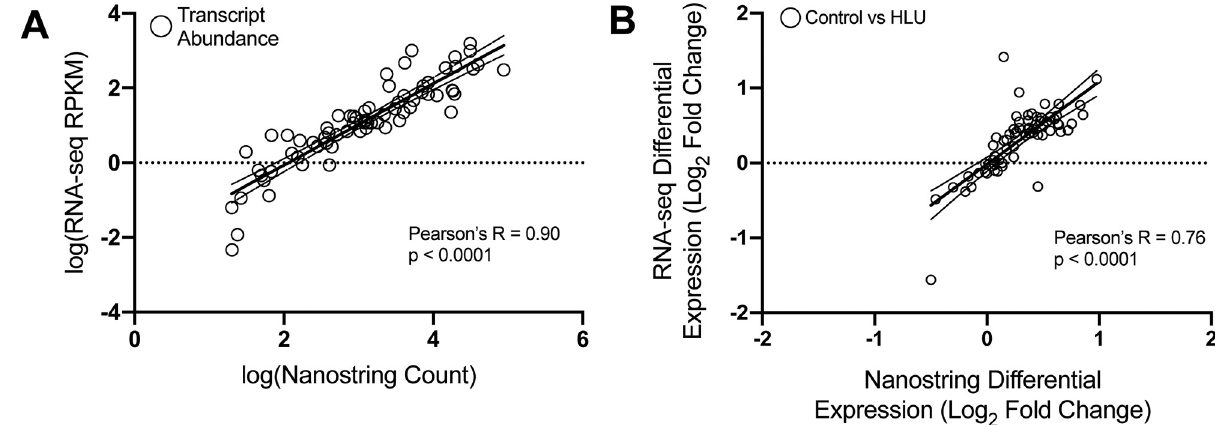
Fig 2. Correlation between Nanostring and RNAseq transcript abundance in controls (A) and changes in abundance between control and HLU mice (B) with 95% confidence bands of the best-fit line.